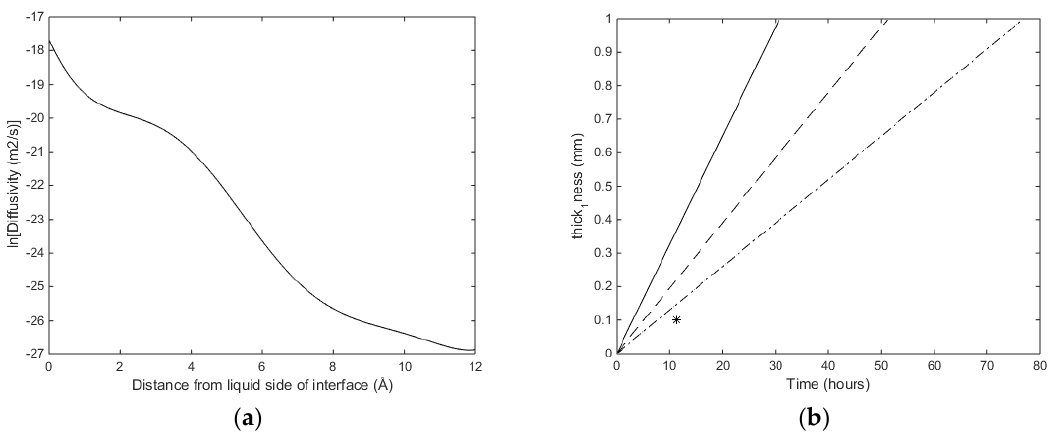
Figure 5. ( a ) Diffusivity profile for D liq = 2·10 − 08 m 2 /s in Equation (16) for CO 2 hydrate. ( b ) Calculated hydrate film thickness as function of time for D liq = 5·10 − 08 m 2 /s (solid), D liq = 3·10 − 08 m 2 /s (dashed) and D liq = 2·10 − 08 m 2 /s (dash-dot). The experimental point (*) is rather uncertain and based on visual reading of a picture in Uchida et al. [31] for a water droplet exposed to CO 2 under hydrate forming conditions.